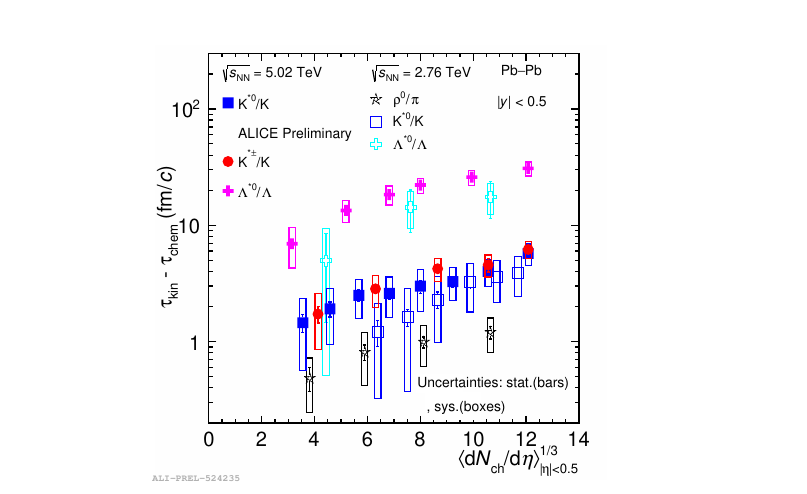
Figure 2. Lower limit on the hadronic phase lifetime between chemical and kinetic freeze-out as a 1 / 3 for di ff erent resonances in Pb-Pb collisions at LHC energies. The statistical function of d N ch / d η (cid:31) (cid:30) and systematic errors are represented by vertical bars and boxes around the data